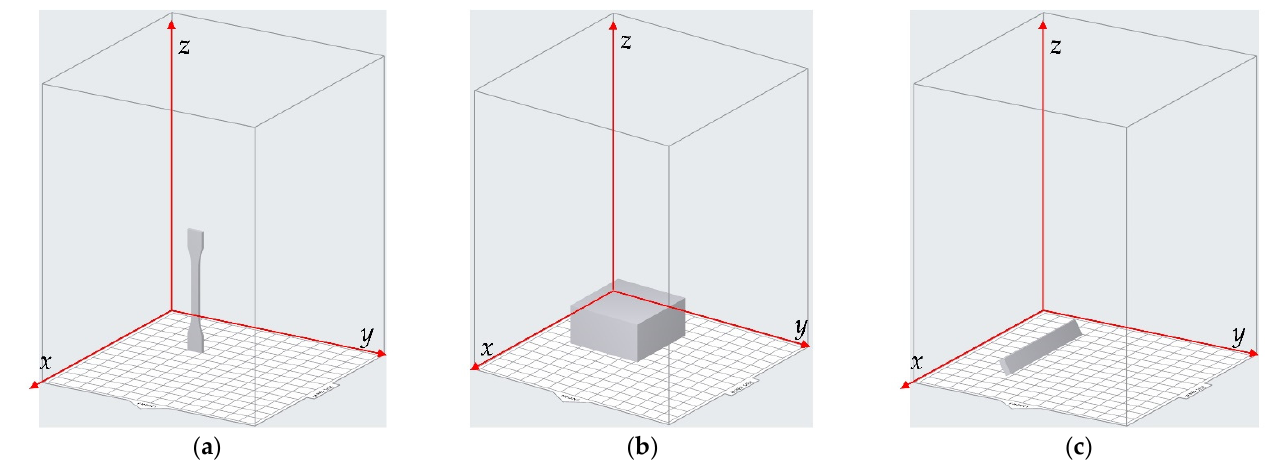
Figure 9. The printing orientations for the worst single mechanical property in Preform software. ( a ) The printing orientation for the worst tensile strength σ b ; ( b ) the printing orientation for the worst compressive strength σ bc ; ( c ) the printing orientation for the worst flexural modulus E .